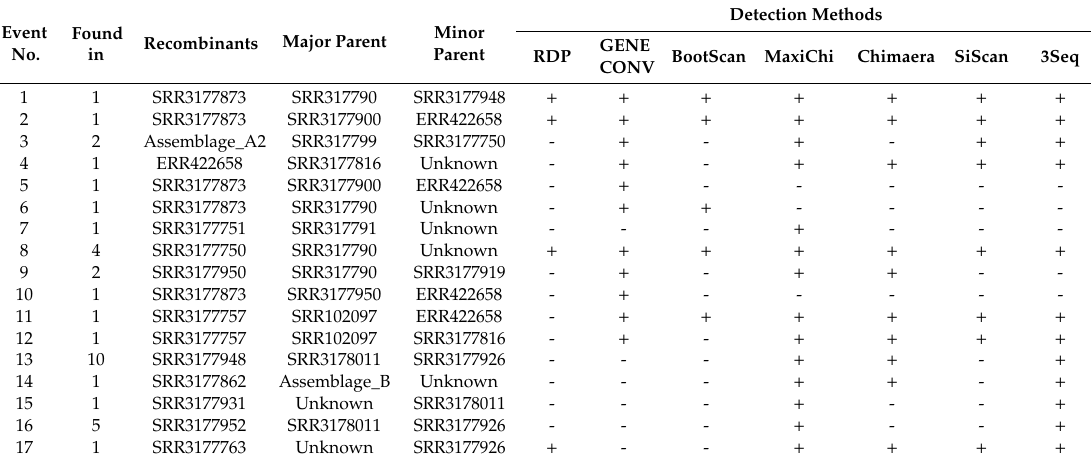
Table 3. Detection of recombination events.